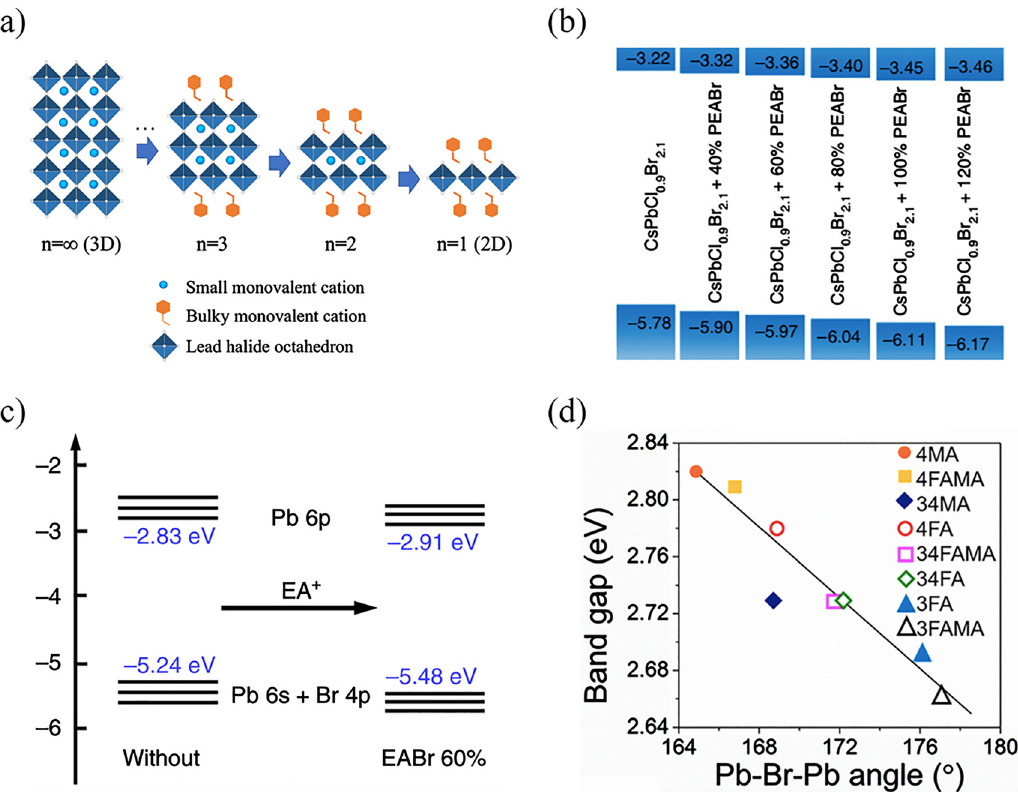
Figure 1: (a) The schematic crystal structures of 3D, quasi-2D ( n = 2, 3) and 2D ( n = 1) RP perovskites with different ratio of bulky organic cations. (b) The VB and CB energy levels of quasi-2D perovskite based on CsPbBr 0.9 I 2.1 with different ratio of PEABr. Reproduced with permission [16]. Copyright © 2019, Springer Nature. (c) The variation of energy levels on insertion of a relative larger organic cation of EA